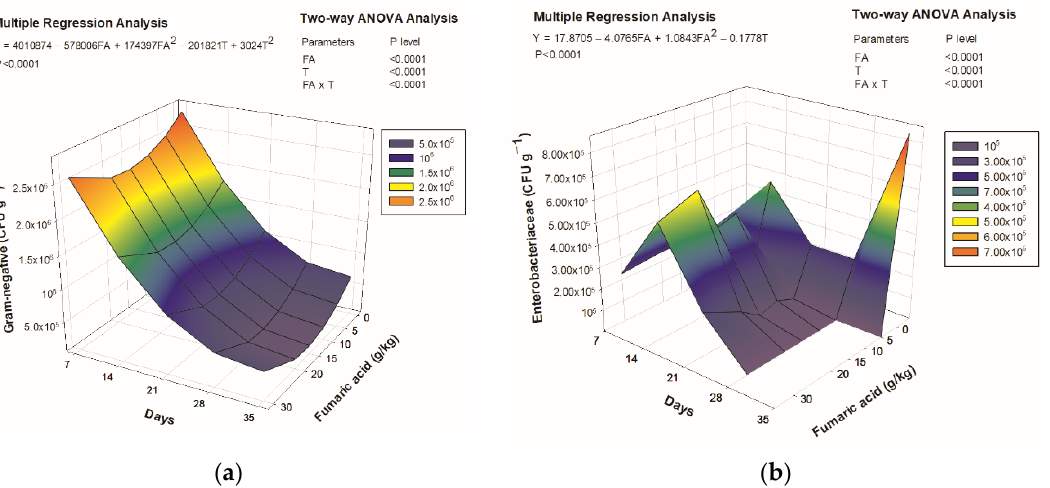
Figure 2. Relationship between bacteria counts in the gut of Nile tilapia juveniles and dietary fumaric acid levels through 35 days: ( a ) Gram negative bacteria; ( b ) Enterobacteriaceae. FA: fumaric acid level (g/kg); T: time (days).